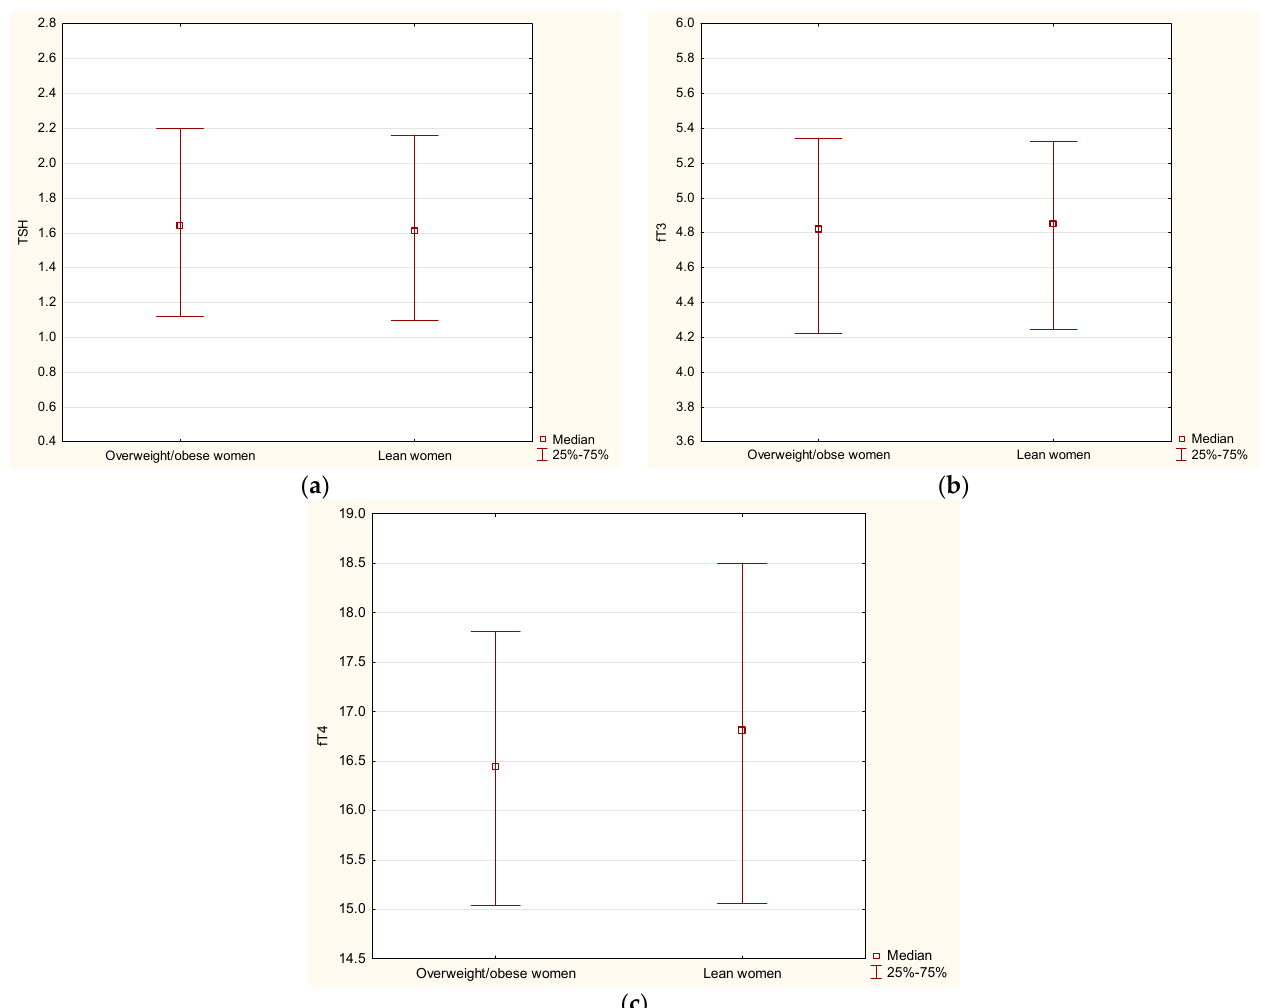
Figure 1. Serum levels of TSH ( a ), fT3 ( b ), and fT4 ( c ) in overweight/obese women ( n = 149) and lean ( n = 160) women.